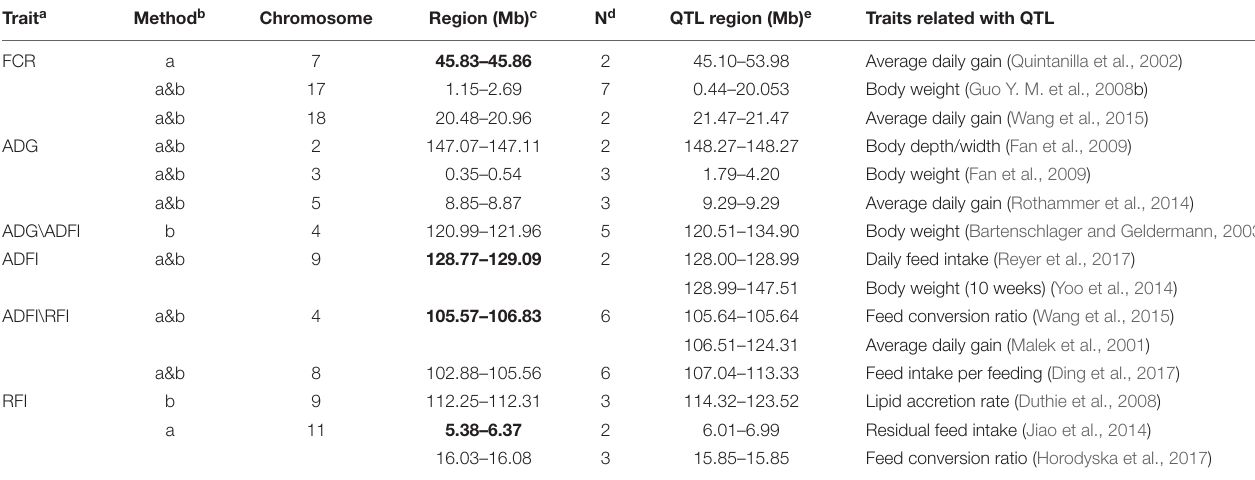
TABLE 2 | Quantitative traits loci (QTLs) related to four feed efficiency traits. Trait a